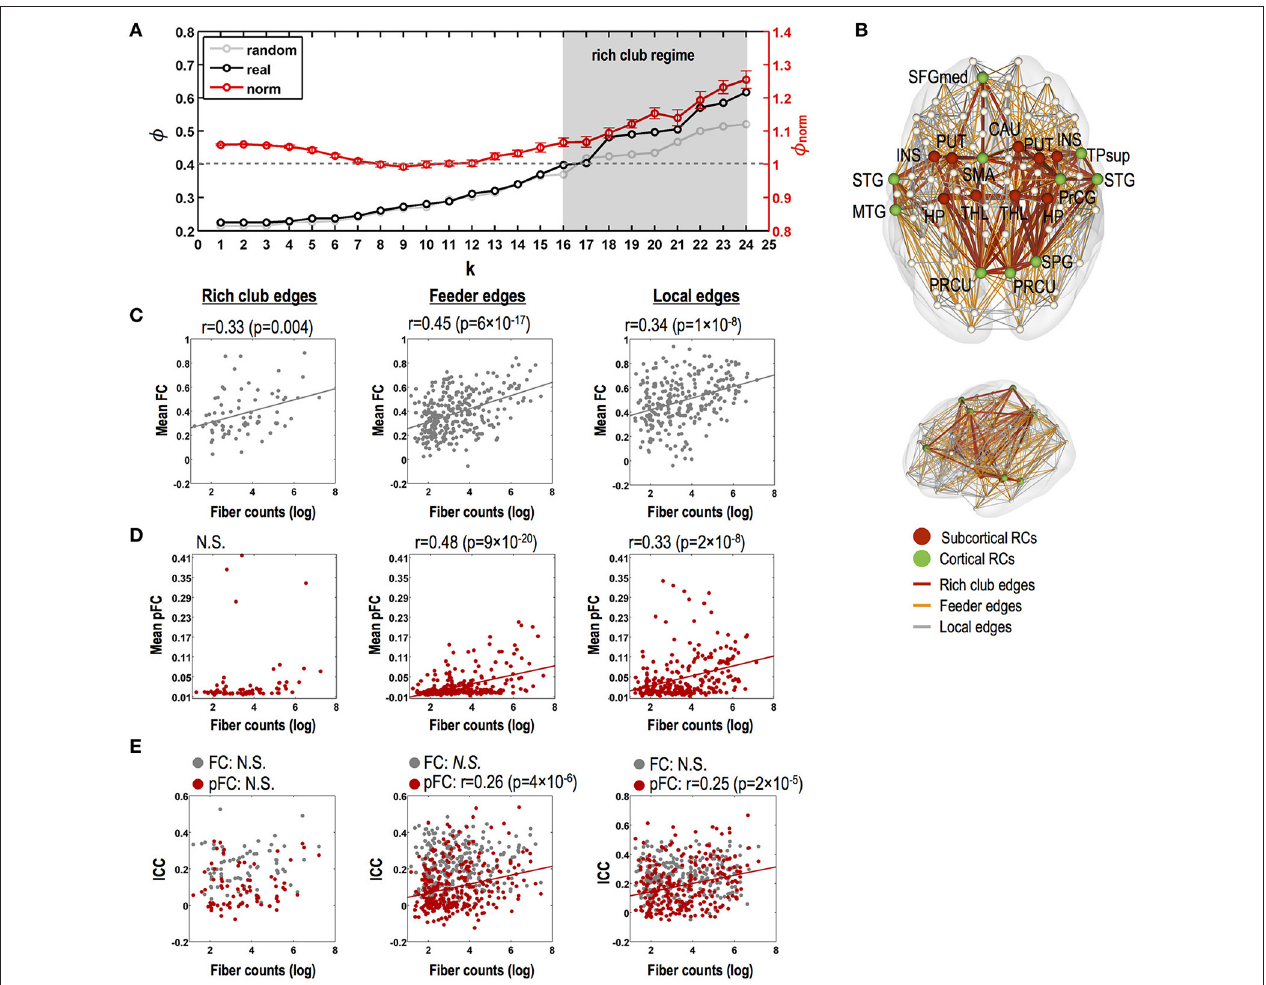
FIGURE 5 | Relationships between stability of functional connectivity and structural connectivity according to topological edge types in rich club organization. (A) Significant rich club organization in the range of degree thresholds, 16 ≤ k ≤ 24 (gray shade; P < 0.05, Bonferroni corrected). Black line indicates time series of group-averaging rich club coefficients with changing degree threshold of k. Light gray line indicates time series of mean rich club coefficients for 1,000 random networks and red line and its error bar represent mean normalized rich club coefficients and its standard error of mean. (B) Rich club nodes by a degree threshold of k = 18 and three kinds of structural edges (i.e., rich club, feeder, and local edges). (C) Relationships between strength of FC and log-transformed fiber counts in rich club, feeder, and local edges for FC. (D) Relationships between strength of pFC and log-transformed fiber counts in rich club, feeder, and local edges for FC. (E) Relationships between stability (ICC) and strength of FC (gray circles lines) and pFC (red circles and regression lines) and log-transformed fiber counts in rich club, feeder, and local edges. N.S. indicates no significance. THL, thalamus; PUT, putamen; PRCU, precuneus; HP, hippocampus; SFGmed, medial superior frontal gyrus; PrCG, precentral gyrus; STG, superior temporal gyrus; INS, insula; SPG, superior pariental gyrus; TPsup, superior temporal pole; CAU, caudate; L, left; R,